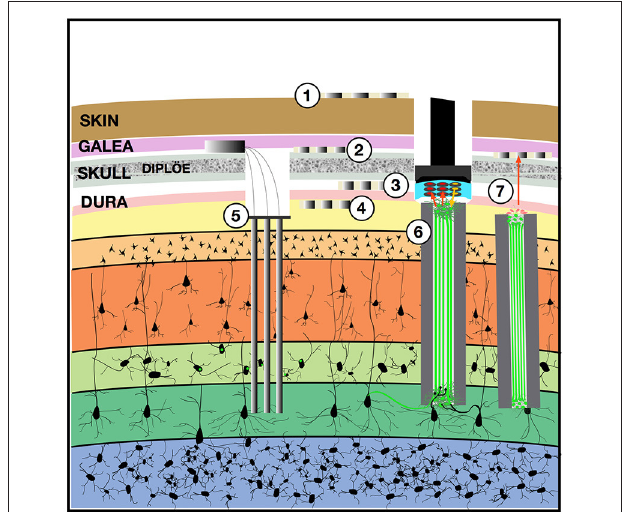
FIGURE 1 | Implantable devices to chronically stimulate and record from the brain. Both low-impedance macro-electrodes and higher-impedance more densely packed electrodes can be used for electroencephalography (EEG) with contacts placed on the (1) scalp, (2) implanted in the subgaleal space without breaching the skull, (3) in the epidural space, or (4) in the subdural space where they may also be termed the electrocorticogram (ECoG) or micro-ECoG (Yu et al., 2016). These electrodes can capture local field potentials and can also be used to pass electrical current. To record ensembles of single units, (5) multi-electrode arrays can be implanted into the cortex, with or without integrated optical fibers. One solution to the apparent biological instability of rigid microelectrodes chronically implanted into the parenchyma, is to create a (6) “living electrode” comprising autologous neurons seeded within an agarose minicolumn that itself can be stereotactically implanted ( Struzyna et al., 2015; Adewole et al., 2016). This three-dimensional living construct can both send axons to stimulate surrounding cortex and receive synapses to capture local activity and transmit this to an aggregate on the cortical surface where a planar optoelectronic array can reciprocally relay recordings and stimulation triggers with an external computer. The externalized aspect of the living electrode (7) could be capped with myocytes to achieve biopotential amplification such that signals could be captured by a subgaleal grid. That grid could in turn wirelessly broadcast signals to external computers. The subgaleal grid could also achieve stimulation of the brain, to provide input and feedback, by transmitting microcurrents to ephaptically modulate the living electrode cap in a manner analogous to the ampullae of Lorenzini in chondrichthyes, chondrostei and teleost fish and monotreme mammalian electroception structures.